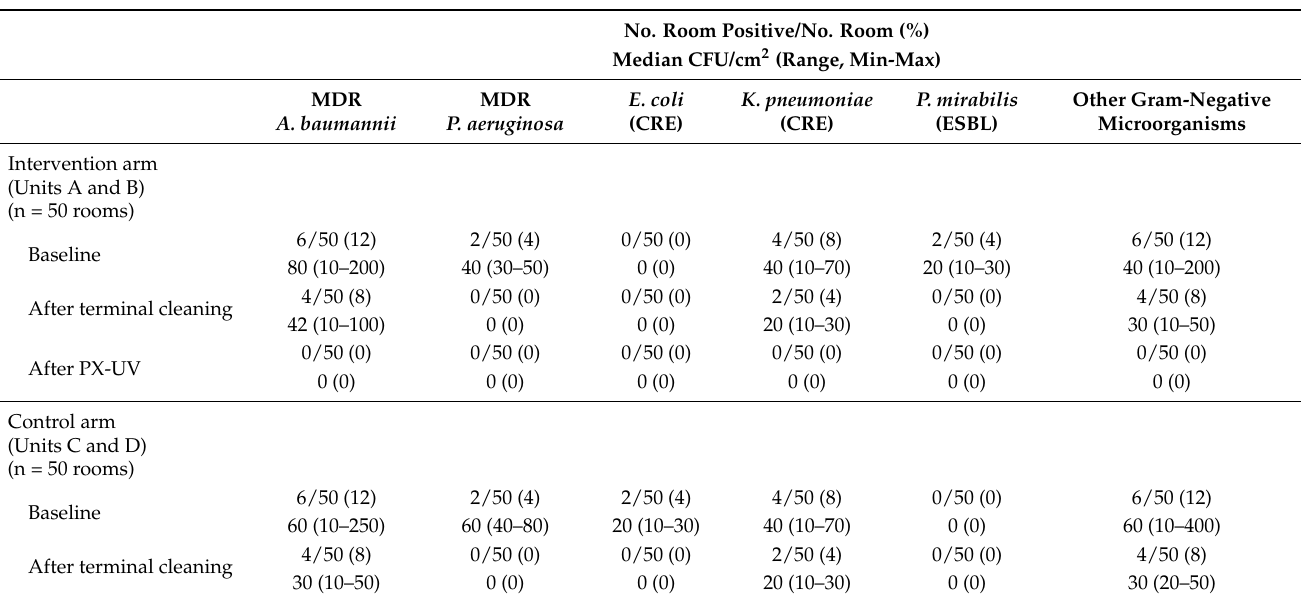
Table 1. Acinetobacter baumannii , Pseudomonas aeruginosa , Escherichia coli, Klebsiella pneumoniae, Proteus mirabilis and other Gram-negative microorganisms at baseline, after standard terminal cleaning and after pulse xenon ultraviolet (PX-UV) disinfection.